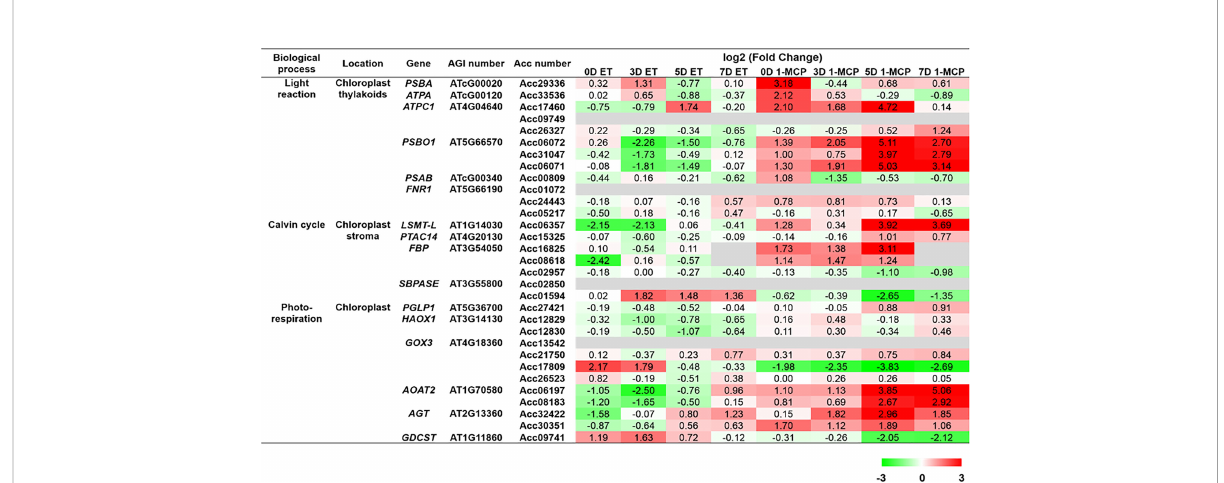
FIGURE 5 Normalized heatmap showing expression levels of photosynthesis-related genes upon ET and 1-MCP treatment along ripening time course. Thirty- one genes related to photosynthesis processes, like light reaction, Calvin cycle, and photorespiration, were found from the Actinidia chinensis genome database, and their expression levels were compared between ET-treated samples and 1-MCP-treated samples along ripening time course (0 days [0D], 3 days [3D], 5 days [5D], and 7 days [7D]). Twenty-seven of 31 total genes (87%) except four genes (Acc01594, Acc17809, Acc26523, and Acc09741) were highly upregulated upon 1-MCP treatment in at least one time point during ripening compared to those of ET-treated samples. ET, ethylene; 1-MCP, 1-methylcyclopropene; gene, Arabidopsis gene name; AGI, Arabidopsis gene index; Acc, A. chinensis